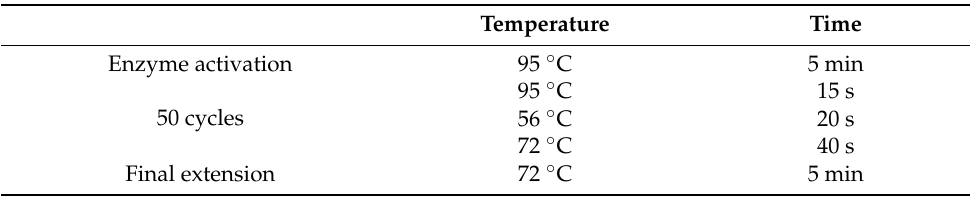
Table 1. The protocol of qPCR.